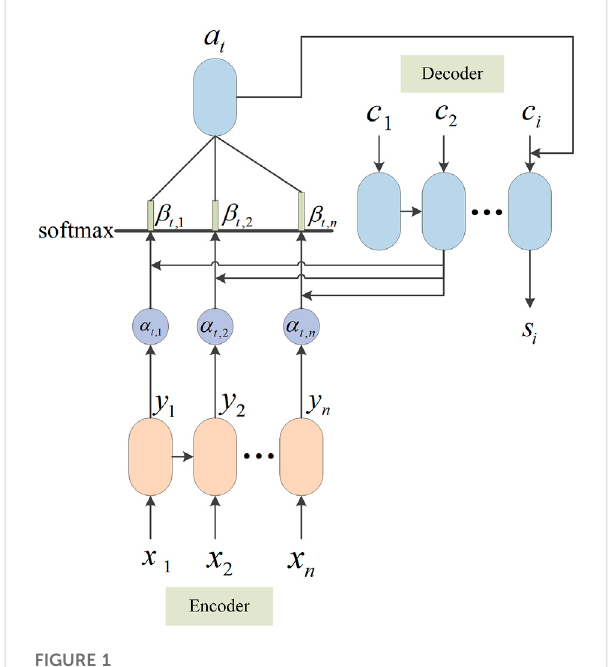
FIGURE 1 Schematic diagram of attention